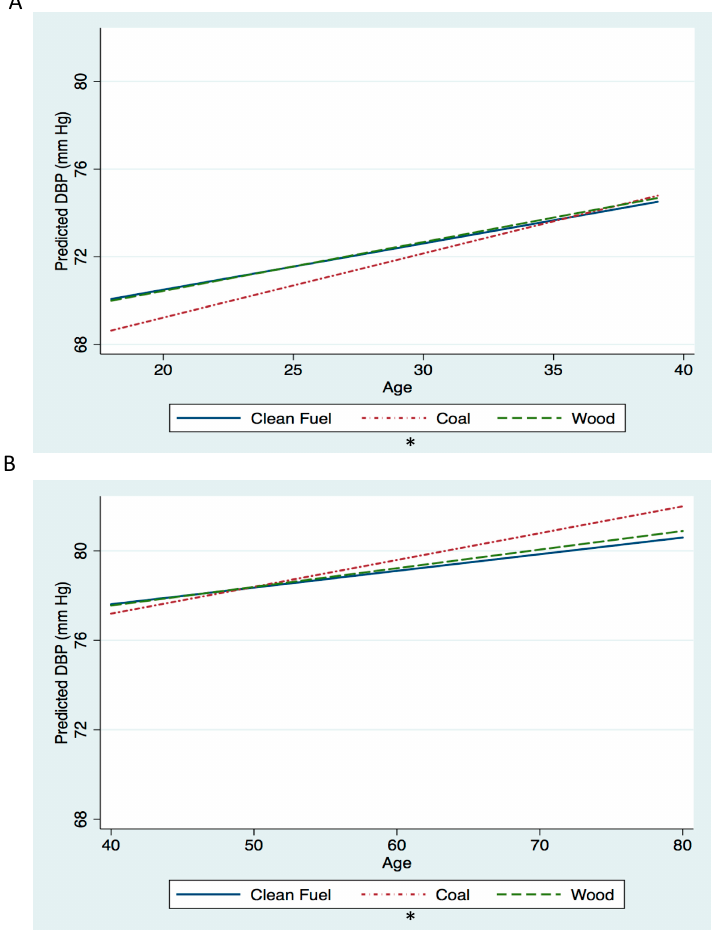
Figure 3. Diastolic blood pressure (DBP) by age according to cooking fuel category among nonpregnant women aged living in rural areas of China (n = 22,118 observations from n = 6671 women, median observations per woman 3). Panel A is the model for women <40 years of age. Panel B is the model for women ≥ 40 years of age. All models controlled for the following covariates: fuel category, age (years), fuel category*age, survey year (categorical, reference = 2011), survey year*age, baseline income quintiles (categorical, reference = 3rd quintile), baseline income quintiles*age, urbanicity index quintiles (categorical, reference = 3rd quintile), urbanicity index*age, education level (categorical, reference = “some primary level education”), education level*age, alcohol intake (consumer / not consumer, reference = not consumer), alcohol intake*age, ever smoked (yes / no, reference = no), ever smoked*age, baseline BMI (kg / m 2 ), and baseline BMI*age. In order to obtain predictive values, variables were set to reference values for categorical variables and median values for continuous